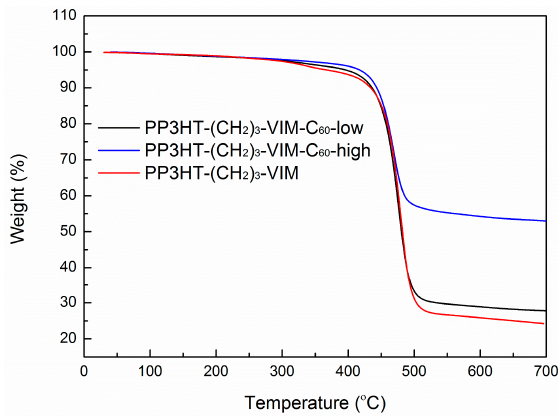
Figure 10. TGA curves of PP3HT-(CH 2 ) 3 -VIM, P[P3HT-(CH 2 ) 3 -VIM-C 60 -low] and P[P3HT-(CH 2 ) 3 -VIM-C 60 -high].